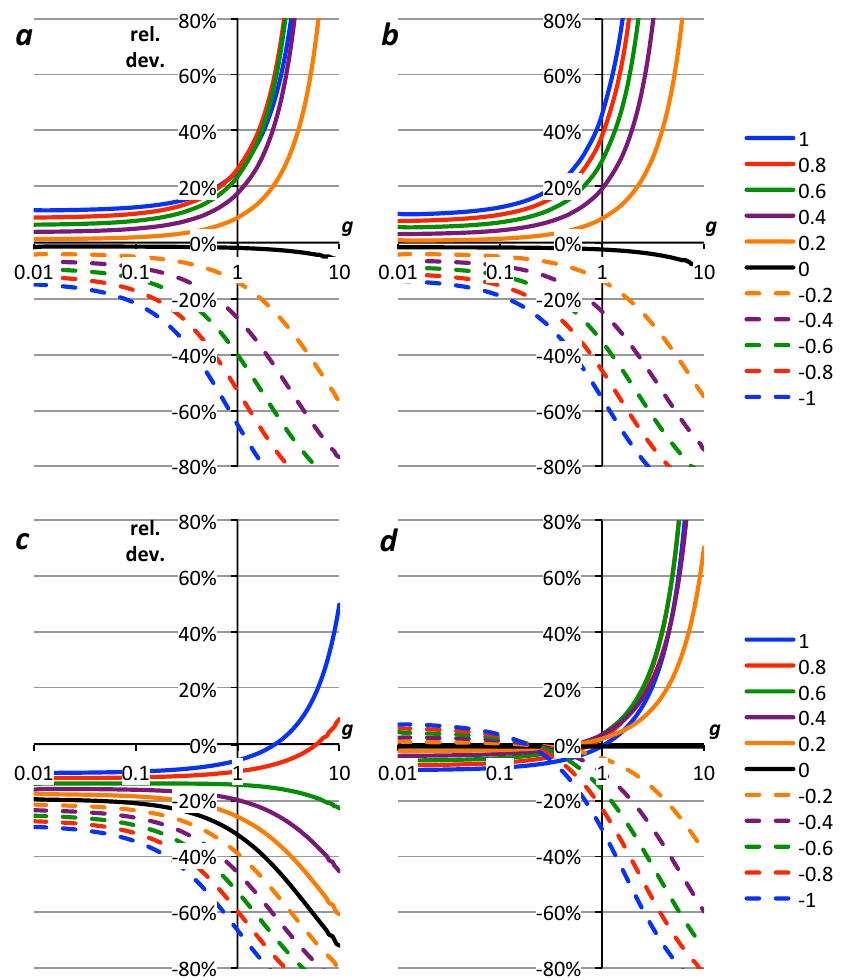
Fig. 3. Relative deviation of the approximated solution for g (Eq. 10) from the accurate solution (Eq. 1) for the parameters in Table 3, row 6m ( δ W based on Barkan and Luz,